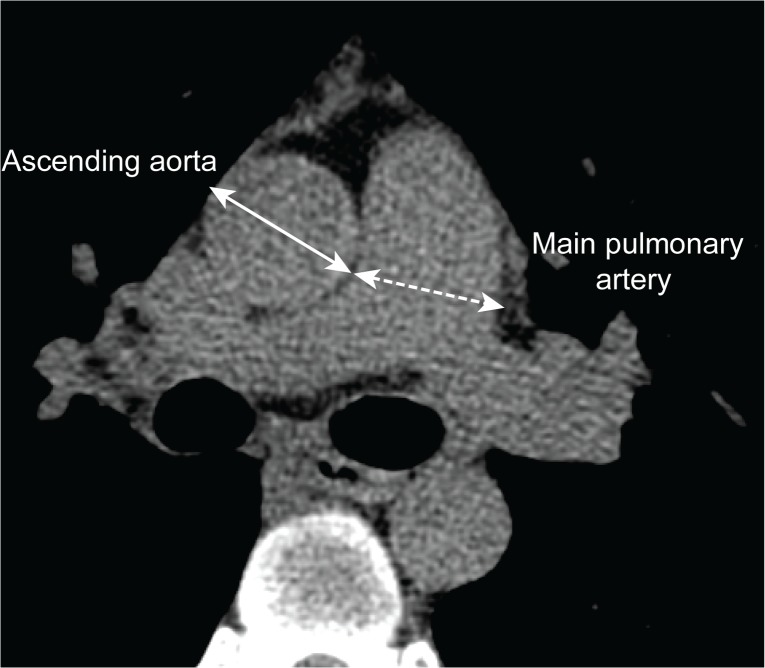
Measurement of the pulmonary artery and ascending aorta diameters.Pulmonary artery and ascending aorta diameters were assessed on a transverse CT image at the level of the pulmonary artery bifurcation. Vessel diameters were obtained by measuring the widest diameter vertical to the long axis of the main pulmonary artery, using a computer caliper. mPA, main pulmonary artery; Ao, aorta